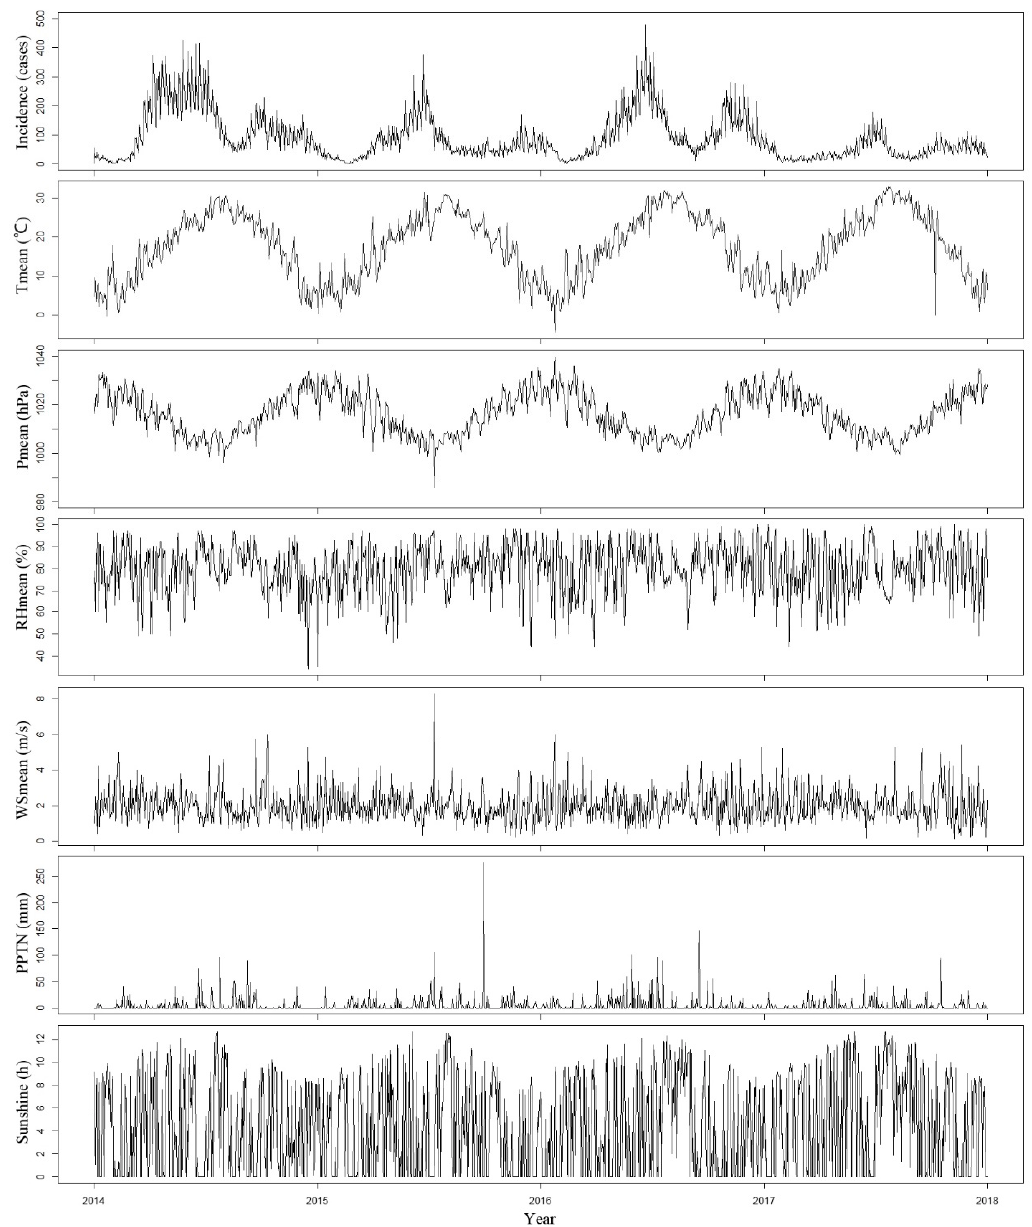
Figure 4. The time series distribution of the daily incidence of HFMD and meteorological variables in Ningbo, 2014 – 2017.